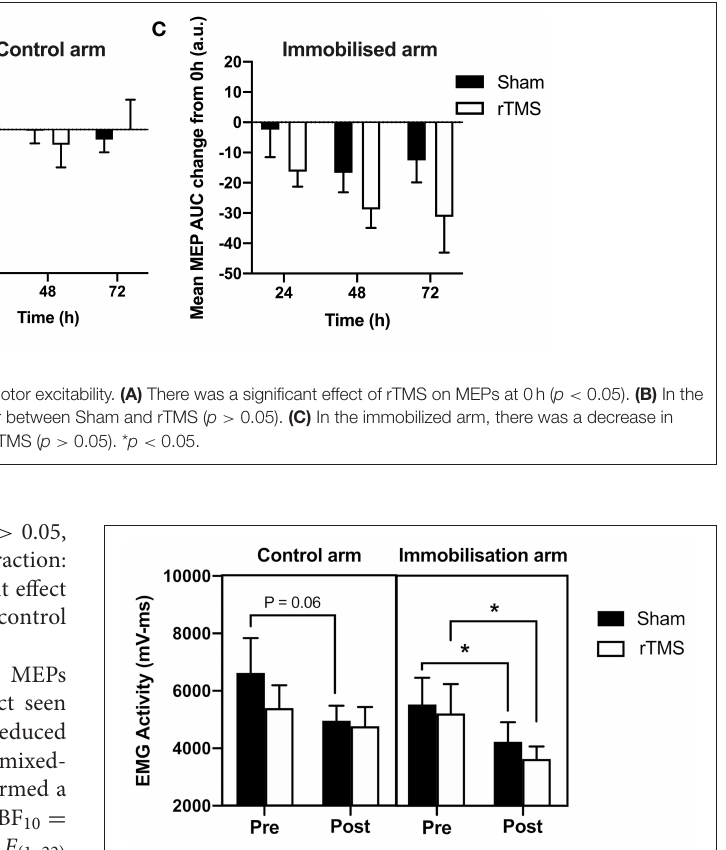
FIGURE 5 | Effect of rTMS on immobilization-induced loss of EMG activity. In the control arm, EMG activity was reduced in the Sham group across the 72h (trend; p = 0.06) but not in the rTMS group ( p > 0.05). In the immobilized arm, there was a loss of EMG activity in the Sham group ( p < 0.05) and this was not prevented with rTMS ( p < 0.05). * p <